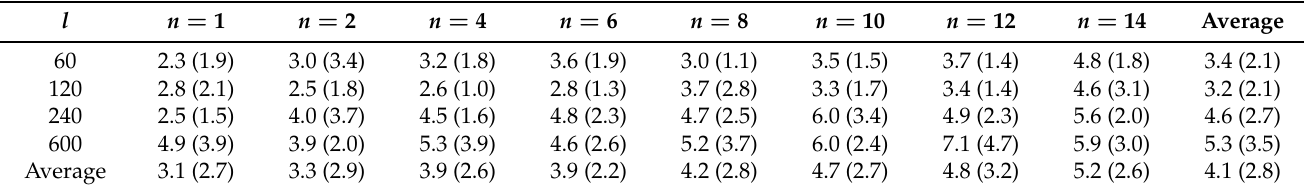
Table 7. Performance of our algorithm when reconstructing samples with gaps located in the initial or final frames of the trajectories. Means (standard deviation) of RMSE are presented, in cm, per tested